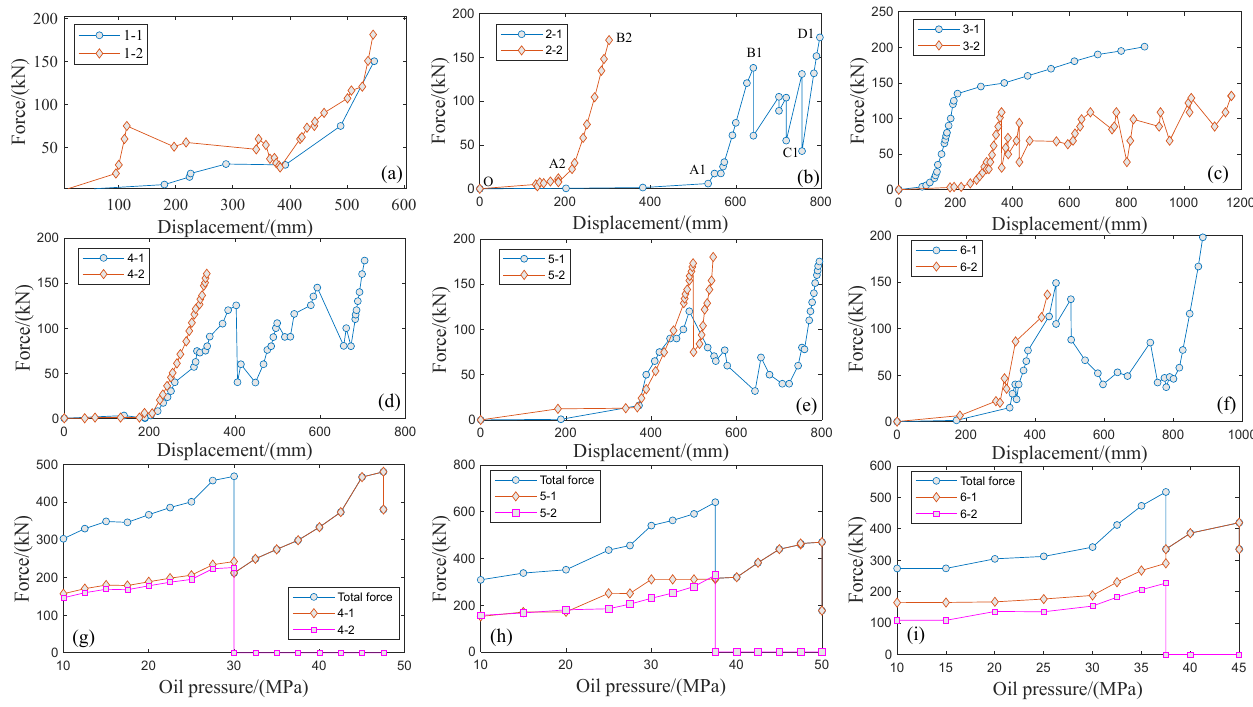
Figure 5. Tension curves of the MSEAs. ( a ‒ f ): The tension processes of MSEAs Nos. 1 ‒ 6, respec- tively; ( g ‒ i ): failure test results of MSEAs Nos. 4 ‒ 6 without grouting, respectively.